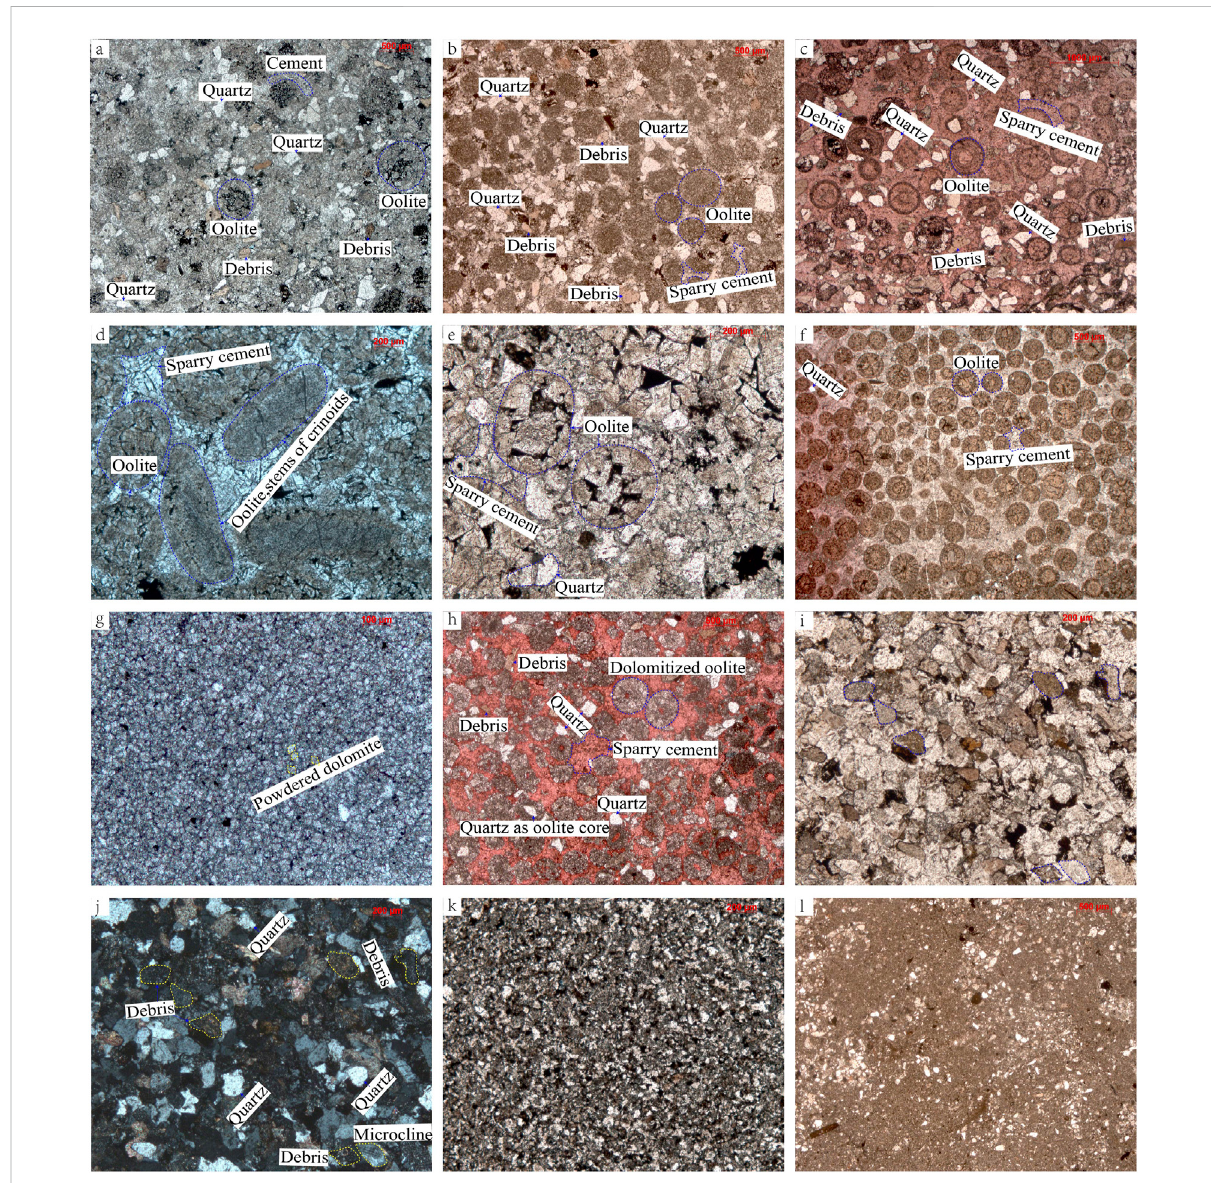
FIGURE 2 Microscopicstructuralfeaturesoftherockinthetarget layer. (A) Sand-bearing ooliticdolomite,Well DB1,5942.7 m,single polarized,dyed cast thin section; (B) Sandy oolitic dolomite, Well PS1, 6784.21 m, single polarized light, dyed cast thin section; (C) Sand-bearing limestone, Well CT1, 6299.5 m, single polarized light, dyed cast thin section; (D) Sparry oolitic dolomite, Crinoid stems can be seen occasionally, Well DB1, 5915.7 m, single polarized, dyed cast thin section; (E) Sparry oolitic dolomite, Well CT1, 6273.18 m, single polarized light, dyed cast thin section; (F) Sparry ooliticlimestone,WellCT1,6301.31 m,singlepolarizedlight,dyedcastthinsection; (G) powderdolomite,WellPS1,6779.41 m,singlepolarized,dyed cast thin section; (H) Dolomite oolitic limestone, Well PS2, 7303.88 m, single polarized light, dyed cast thin section; (I) Fine-grained detrital sandstone, Well PT101, 5024.38m, single polarized light, dyed cast thin section; (J) Cross-polarized light image of sample i; (K) Siltstone, Well PS1, 6777.82 m, single polarized light, dyed cast thin section; (L) Silt mudstone, Well DB1, 5950.7 m, single polarized light, dyed cast thin